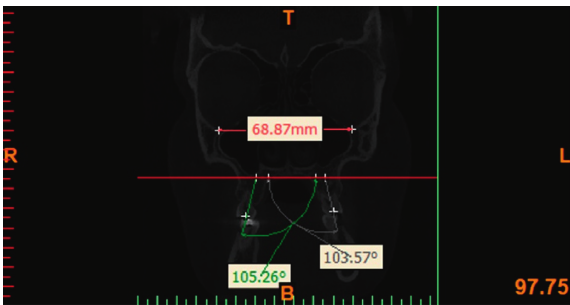
Figure 2: Measuring the inclination of maxillary molars.